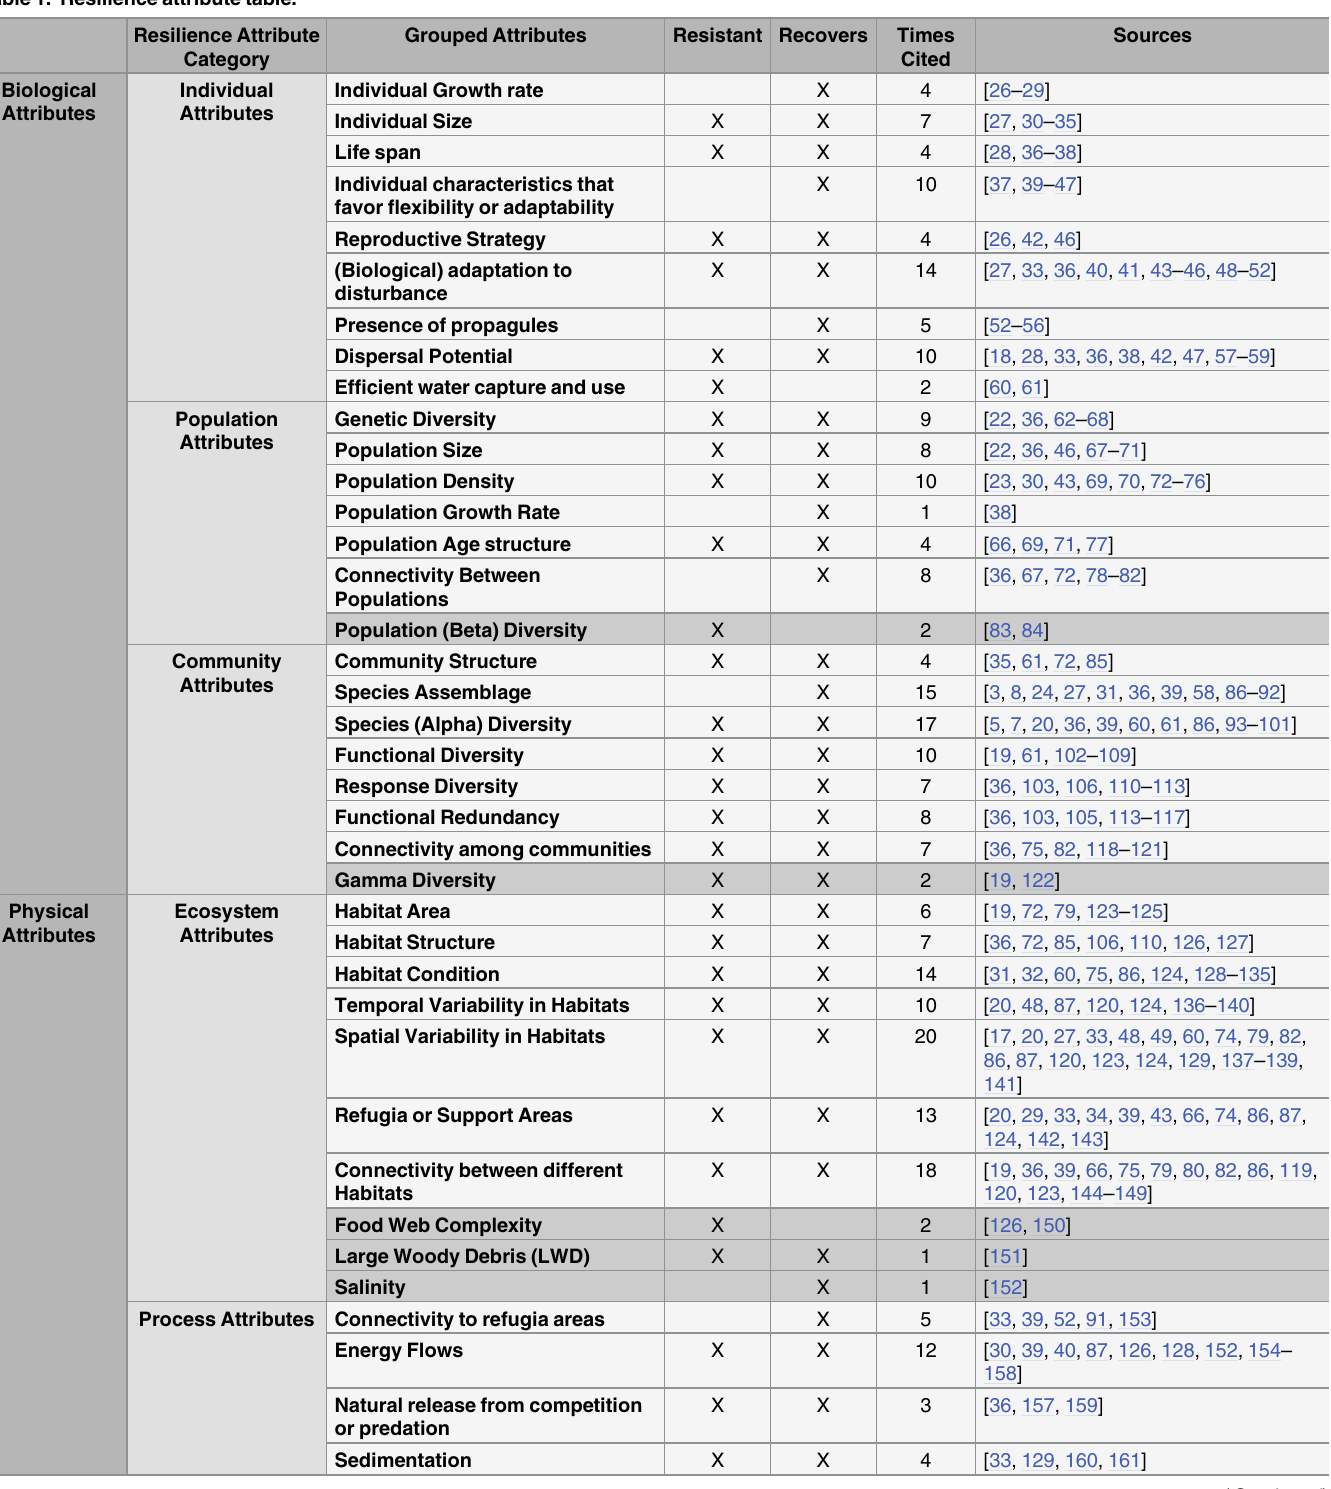
Table 1. Resilience attribute